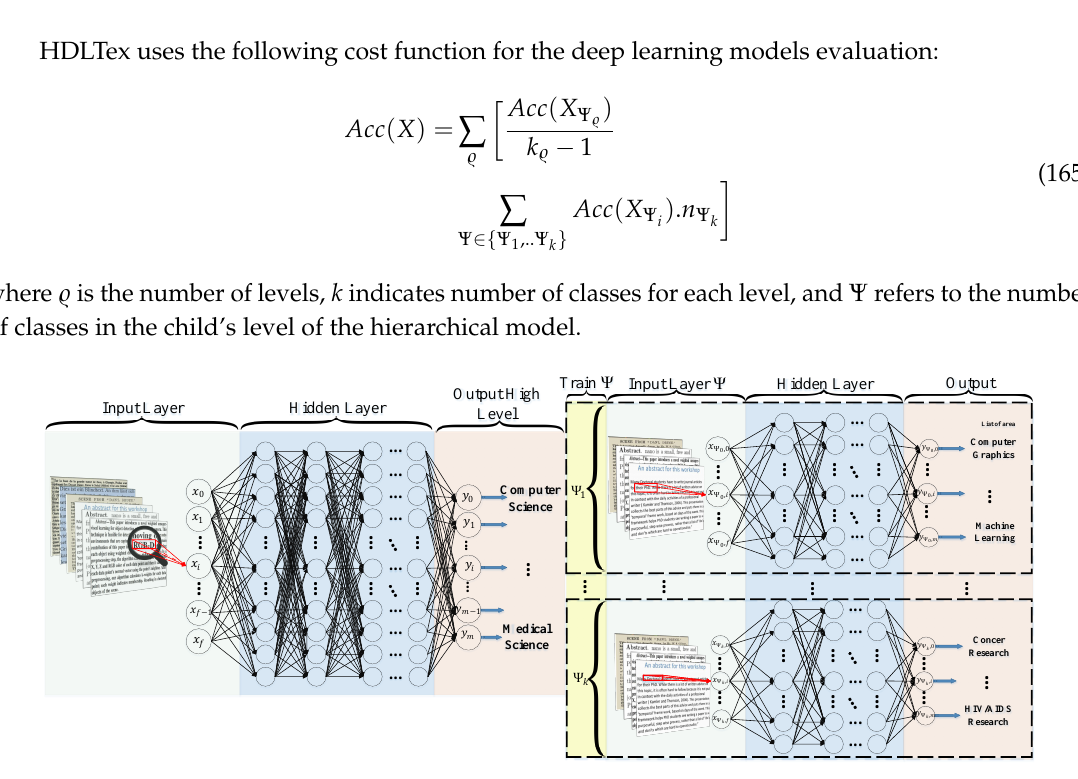
Figure 22. HDLTex: Hierarchical deep learning for text classification. DNN approach for the text classification. The top figure depicts the parent-level of our model, and the bottom figure depicts child-level models ( Ψ i ) as input documents in the parent